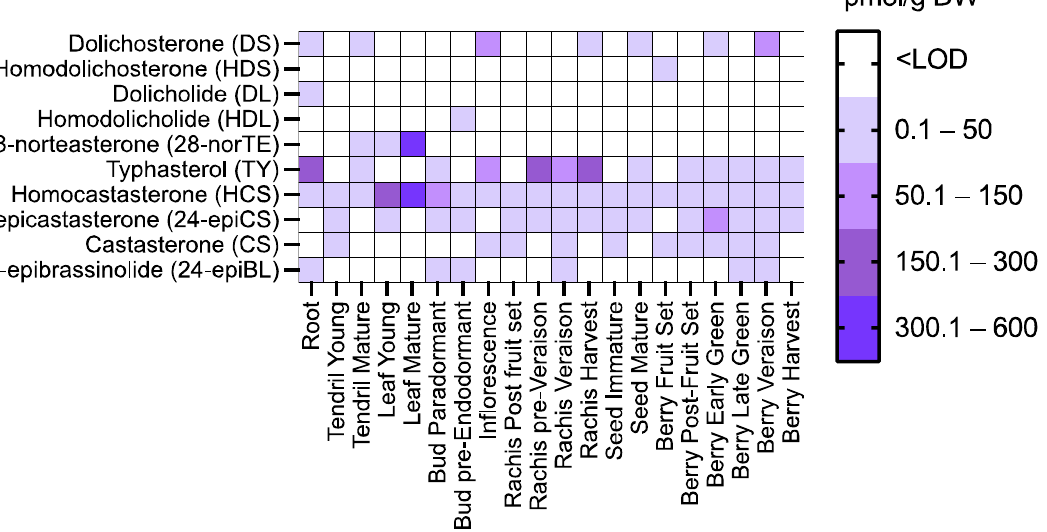
Figure 2. Quantification of brassinosteroids (pmol/g DW) in cv. Cabernet sauvignon grapevine tissues during development. Brassinosteroids were measured by UHPLC-MS/MS, and results were expressed as a heat map. Three biological samples and three technical replicates were measured, with each biological replicate corresponding to a pool of tissue collected from five different plants.